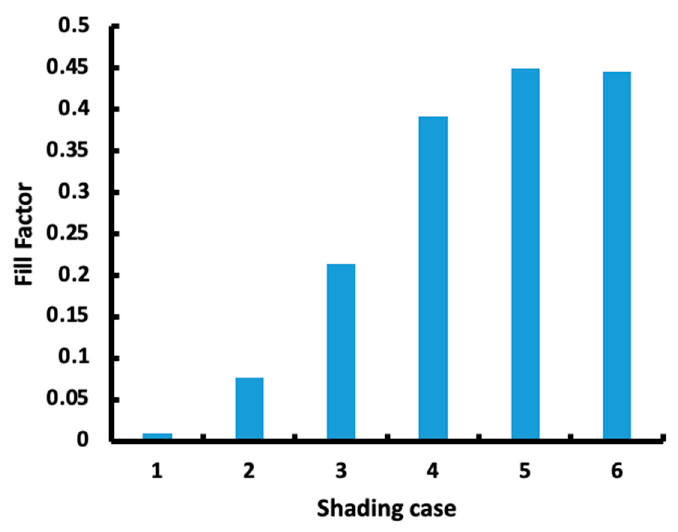
Figure 10. The fill factor for six different PSCs.